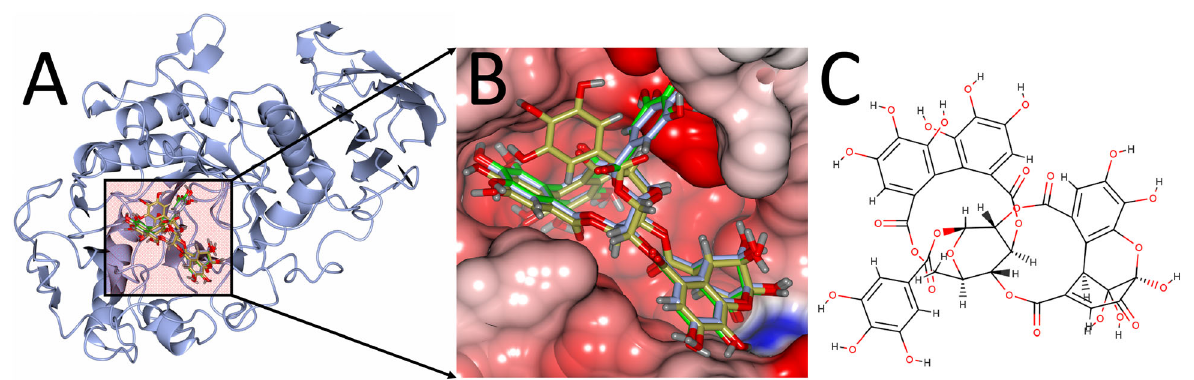
Fig. 4. a Docking of the ligand geraniin on the catalytic site of pig pancreatic alpha-amylase showing that all the programs evaluated found the same pose for this ligand with few differences. b The pose found by Autodock is in green, the pose found by Molegro is in blue and pose found by Gold is in gold. c Chemical structure of geraniin (PubChem CID: 3001497)